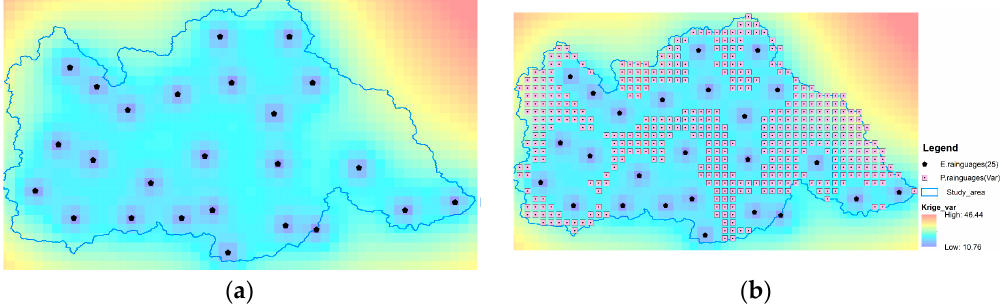
Figure 7. Screening based on Var l ( X ) . ( a ) The spatial distribution of Var l ( X ) and ( b ) the 0.5 quantile potential station distribution based on quantile screening.